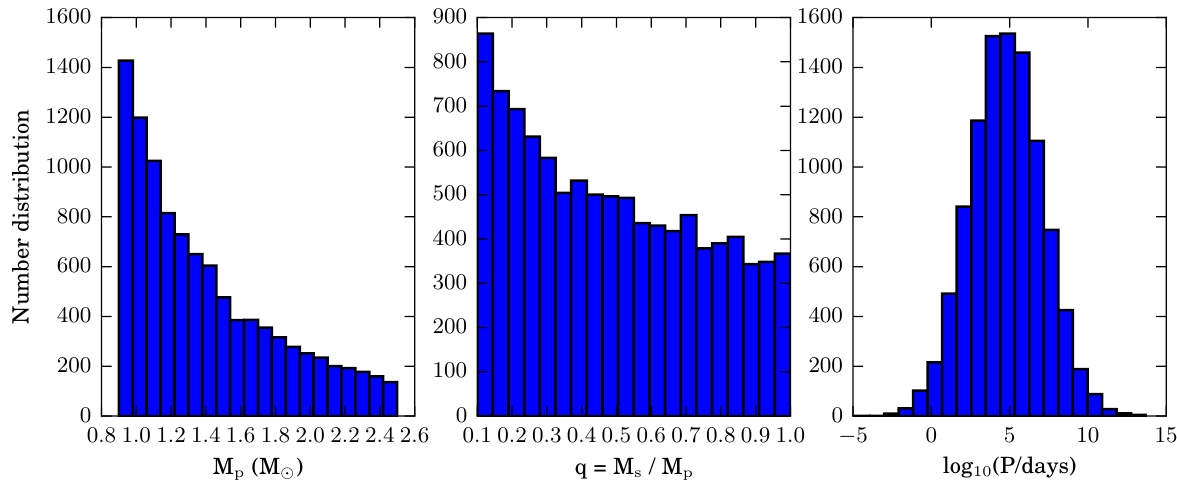
Figure 1. The primary mass (left), mass-ratio (middle) and orbital period distribution (right) used when estimating the fraction of low mass binaries that will undergo mass-loss on the RGB. The primary- mass distribution is the Salpeter IMF, the mass-ratio distribution is based on observations of G-A type binaries in the solar neighbourhood, and the orbital-period distribution is based on observations of G-type binaries in the solar